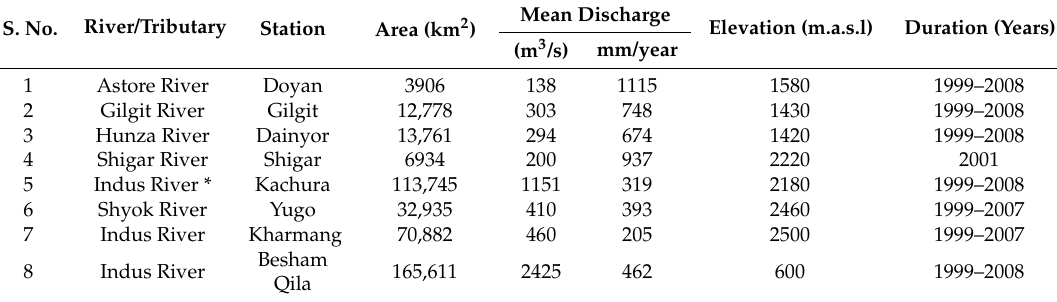
Table 2. Geographical and hydrological attributes of the hydrometric